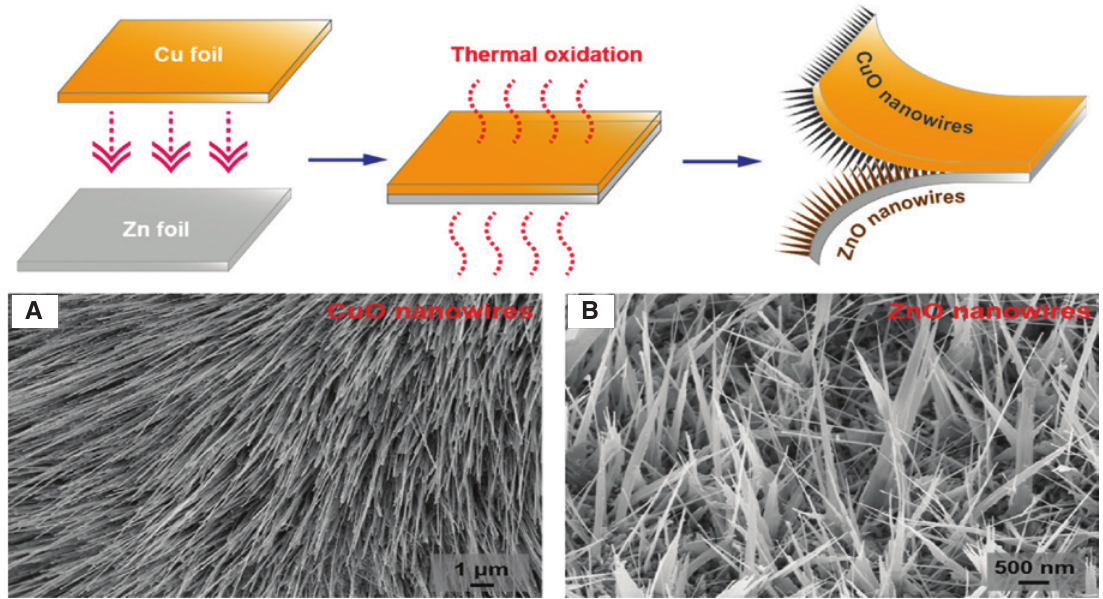
Figure 3: Production of CuO-ZnO nanocomposite by thermal oxidation method. SEM micrograph of (A) p-CuO nanowires and (B) p-ZnO nanowires. Copyrights reserved to Elsevier